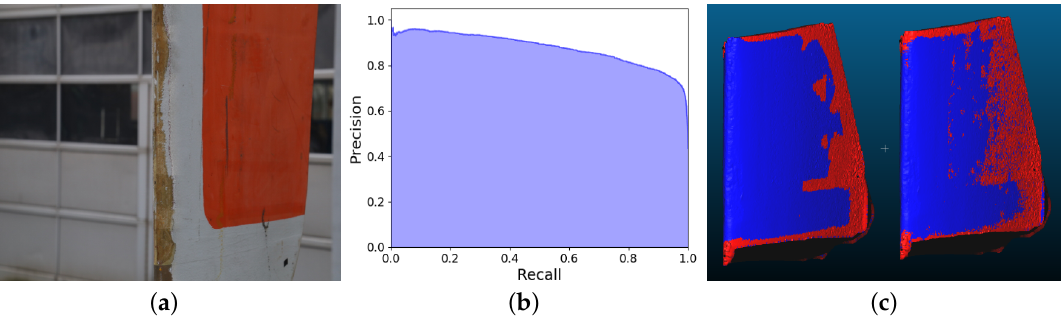
Figure 14. The wind turbine blade used for the second testing scenario ( a ), together with the precision-recall curve of the classification model ( b ) and the visualized annotation compared to classified vertices ( c ). Red vertices are noise, blue are